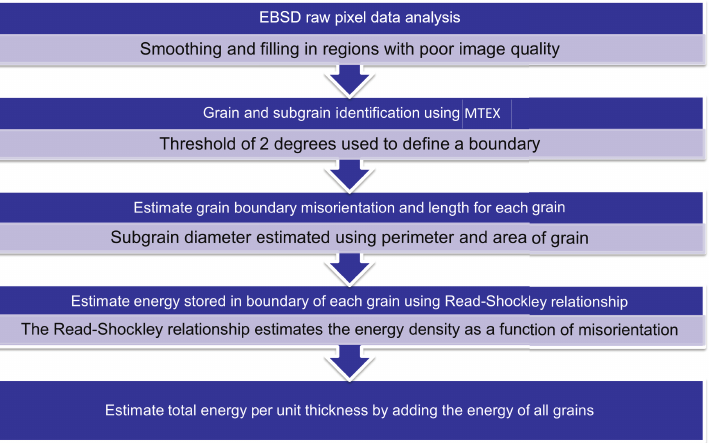
Figure 12. Flowchart showing the method to calculate energy stored in the microstructure from raw EBSD data.